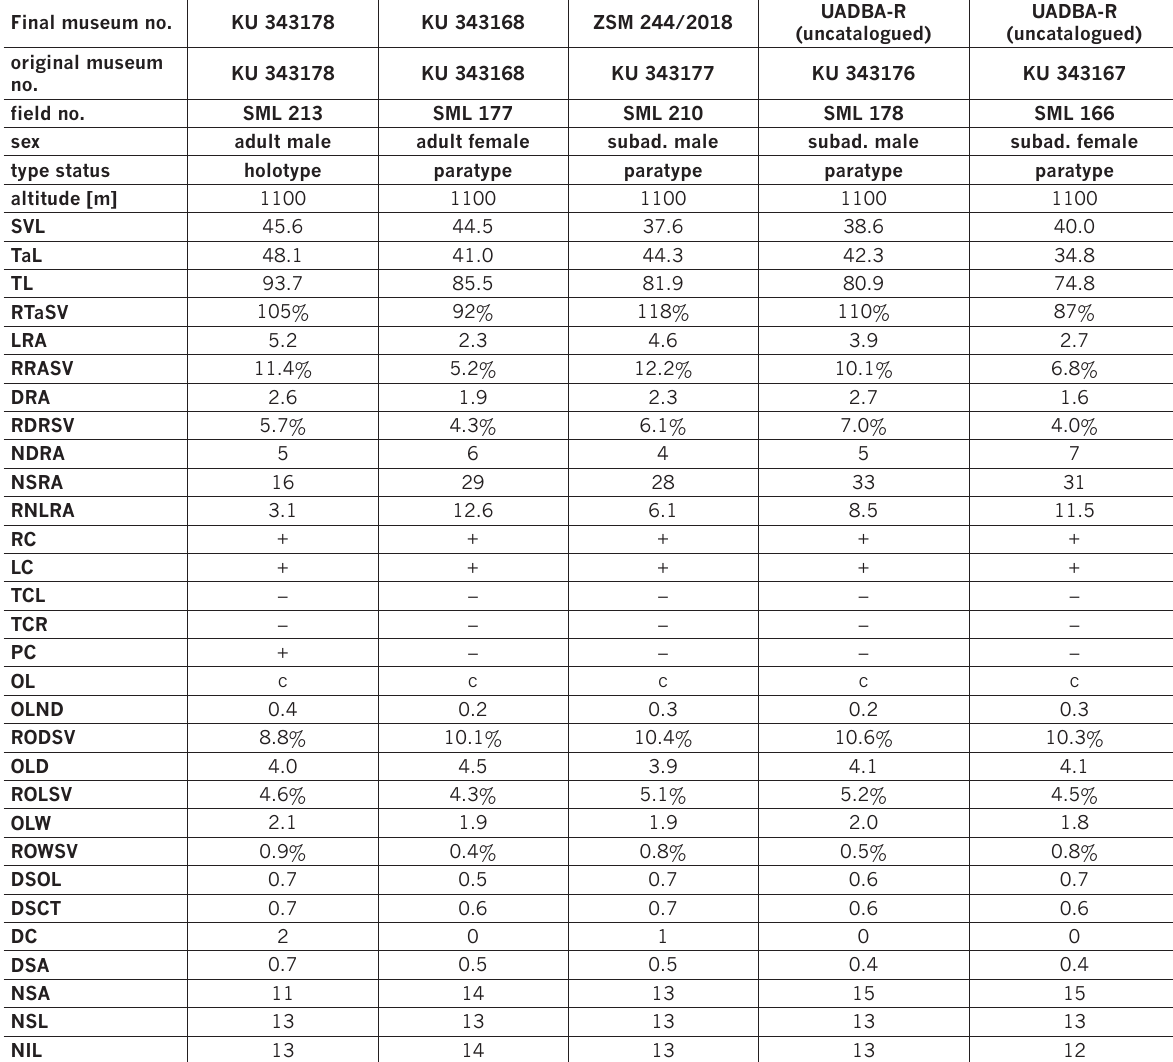
Table 1. Morphological measurements of Calumma roaloko sp. n. All measurements in mm. For abbreviations, see Materials and